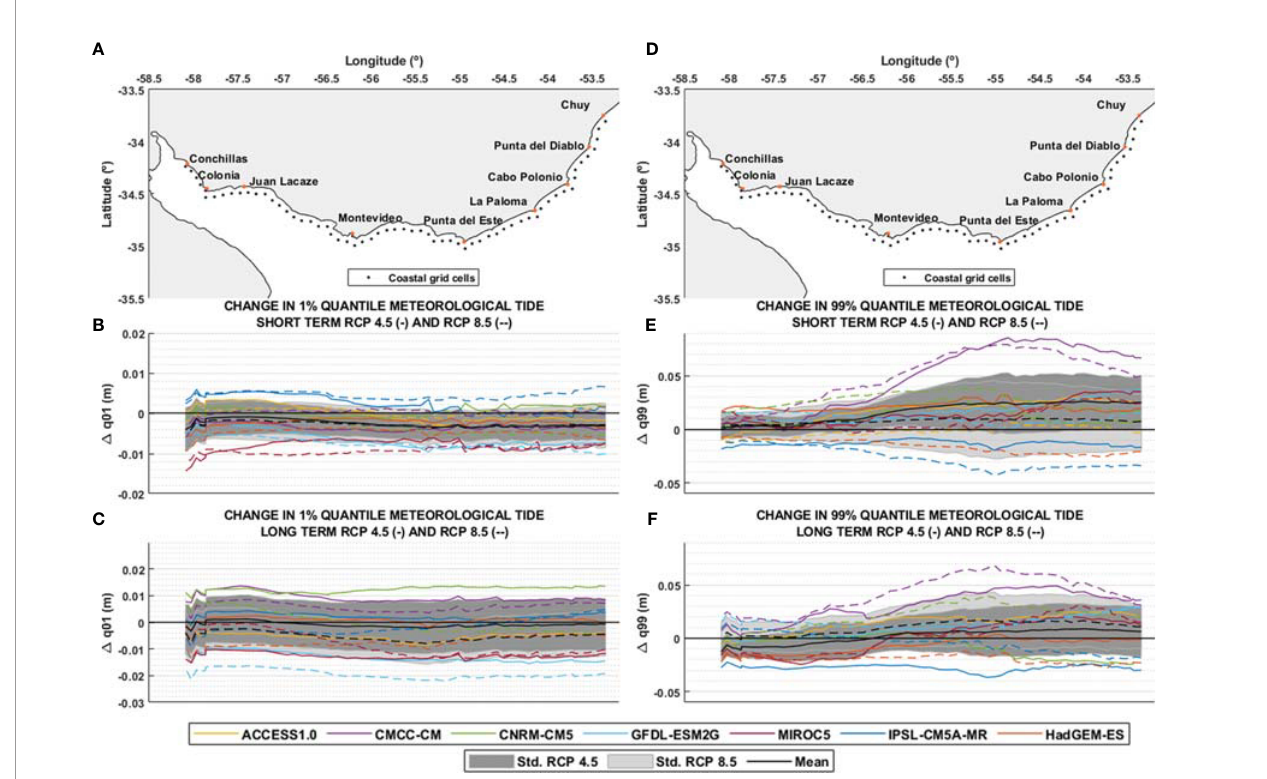
FIGURE 10 | Change in 1% quantile (A – C) and change in 99% quantile (D – F) of T met obtained from local model forced with each GCM and ensemble (black), along the coast for short (2026-2045) and long term (2082-2100) and for RCP 4.5 (continuous lines) and RCP 8.5 (dotted lines). E.g.: change in 99% quantile for the short term is calculated as the difference between 2045-2026 99% quantile and 1986-2005 99% quantile. (A, D) : coastal grid cells. (B, E) : change for short term. (C, F) : change for long